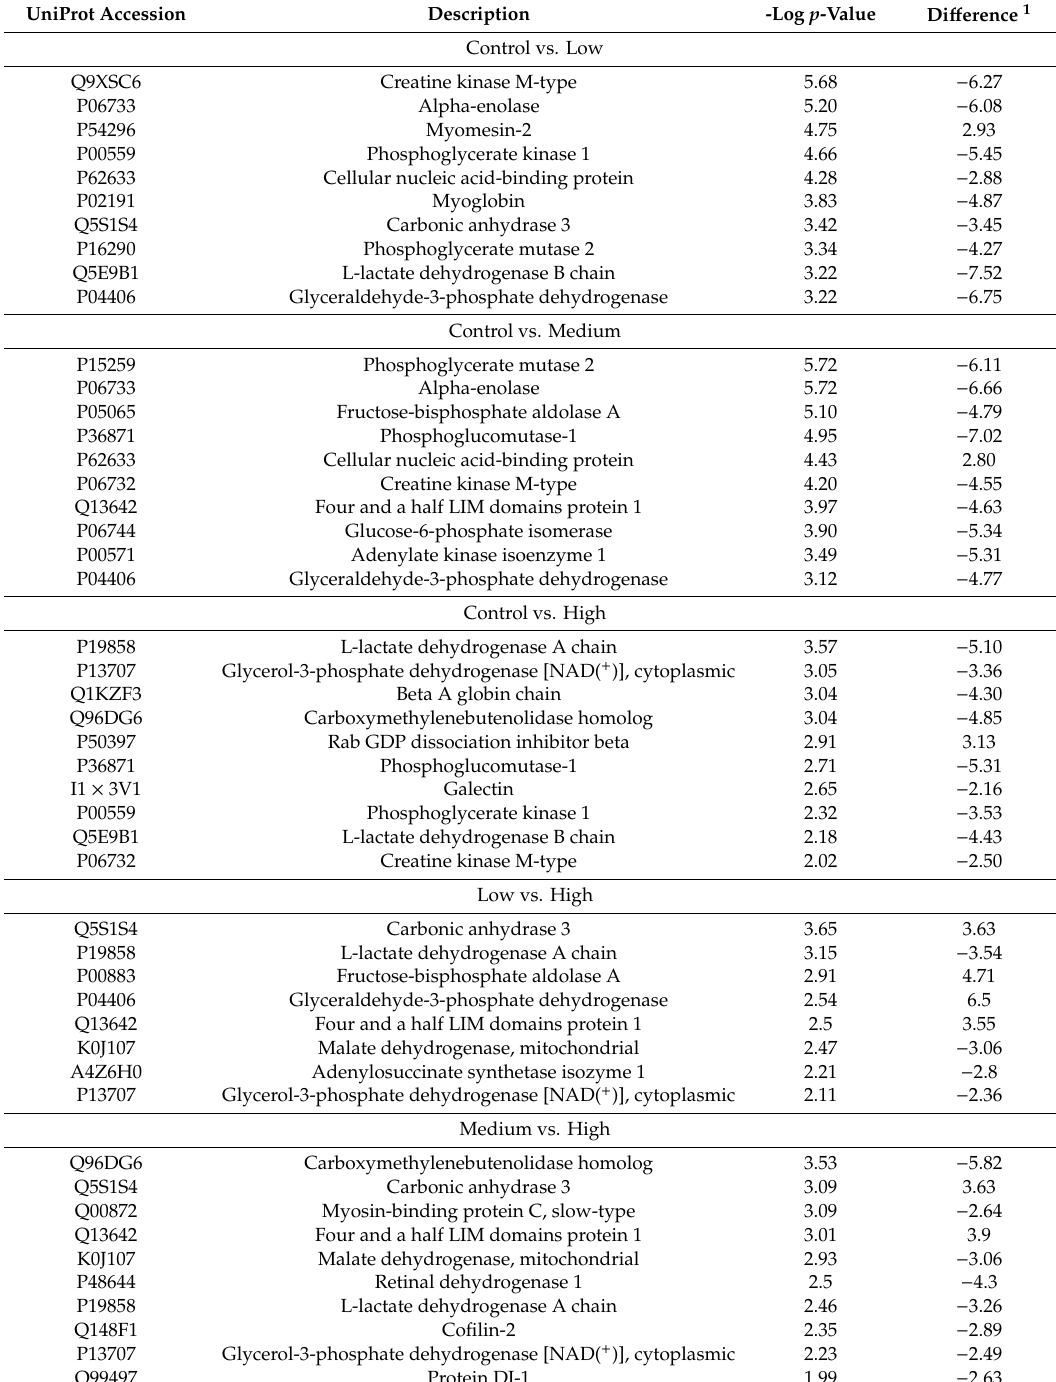
Table 3. Top 10 di ff erentially expressed proteins in the Control vs. Low, Control vs. Medium, Control vs. High, Low vs. High and Medium vs. High